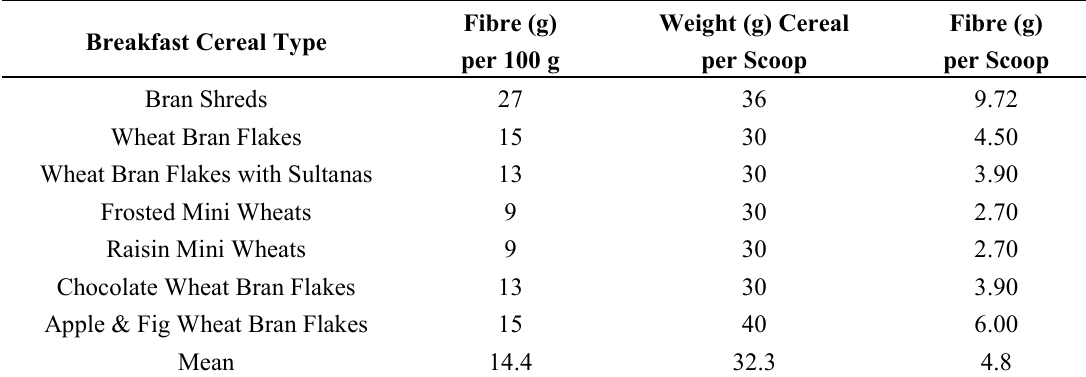
Table 1. Fibre content of the provided breakfast